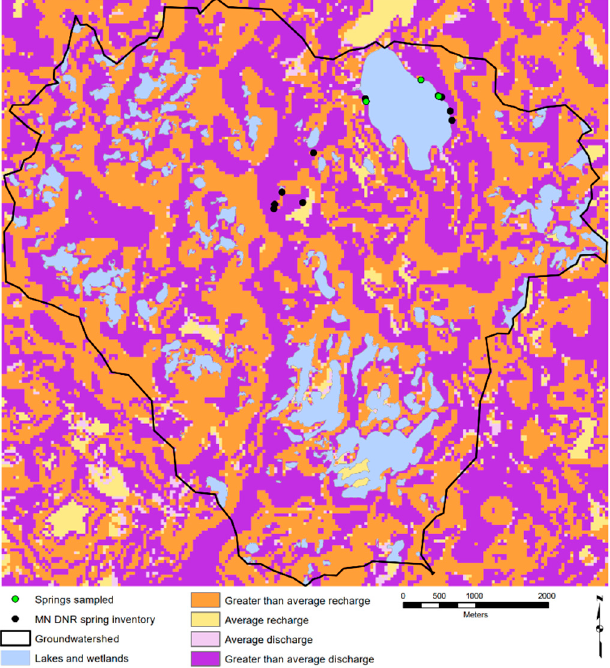
Figure 13. Recharge–discharge map for the study area computed from the interpolated water-table surface based on the unfilled 40 × 40-m resolution raster. Areas of bolder color indicate greater than regional recharge (orange) and discharge (magenta) estimates, lighter colors indicate less than average rates (based on regional analysis [54]).